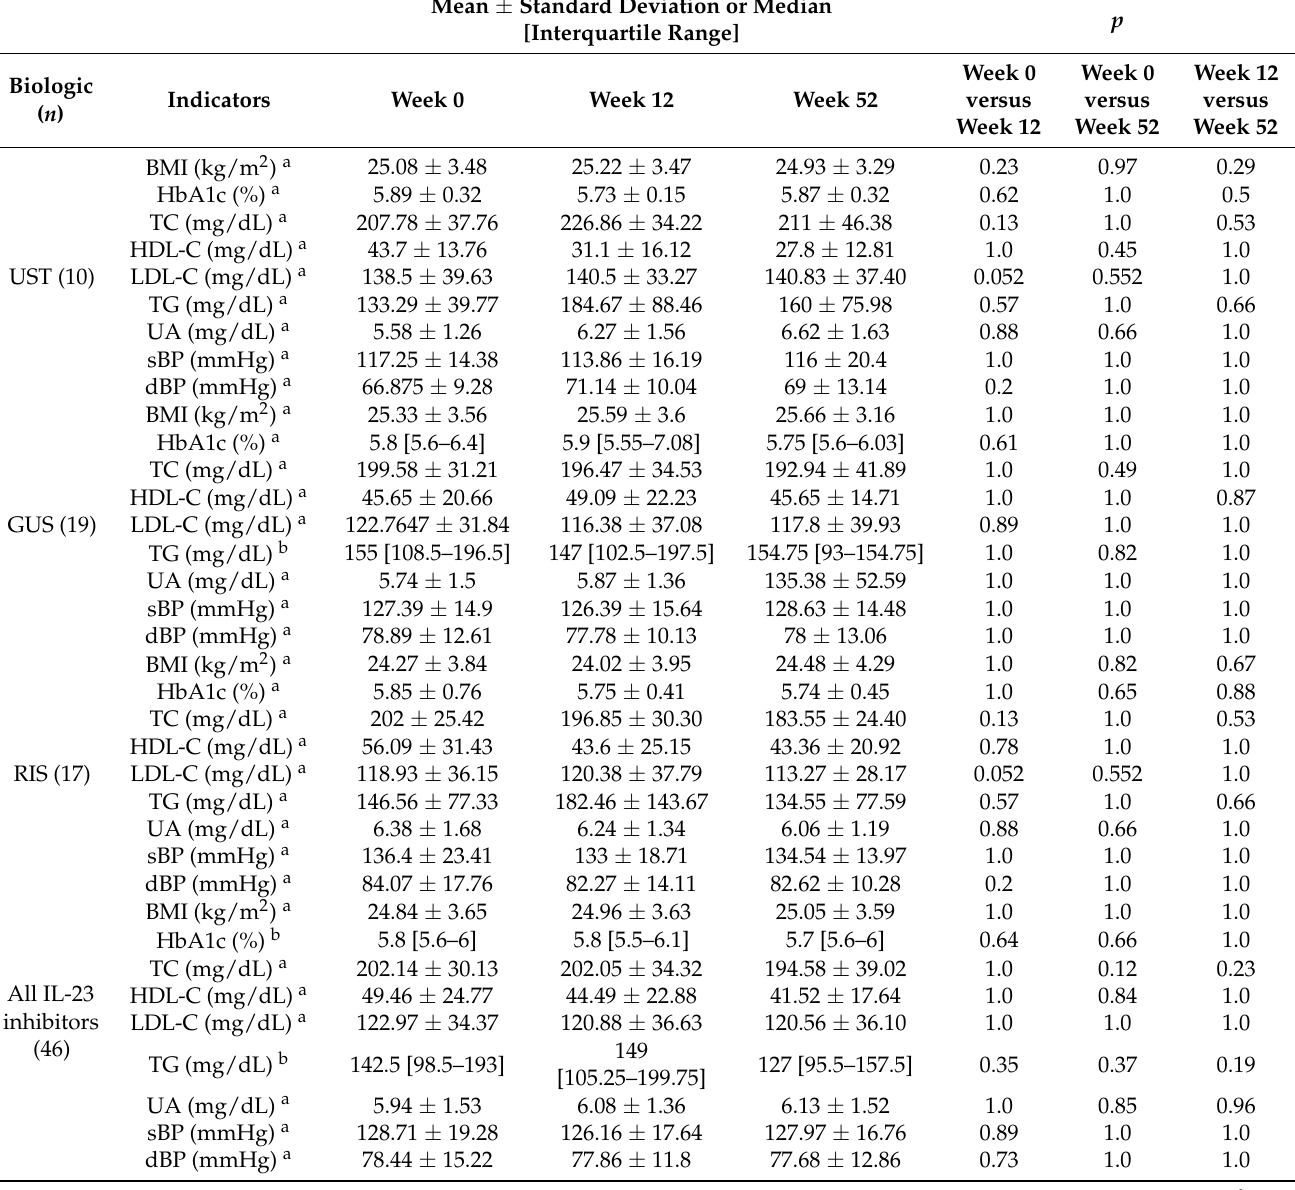
Table 5. The levels of indicators of cardiometabolic diseases at week 0, 12, and 52 of treatment with IL-23 inhibitors. Mean ± Standard Deviation or